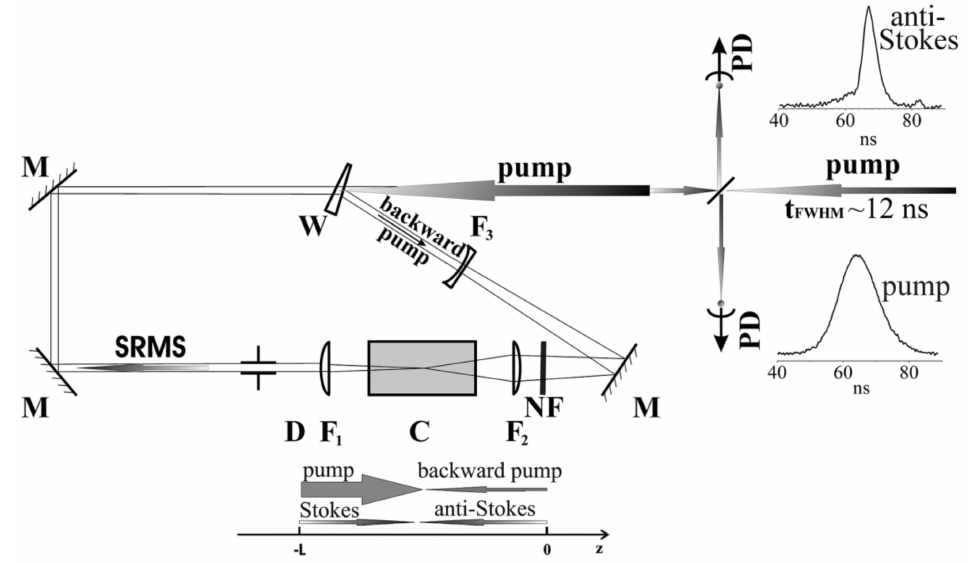
Figure 3. Experimental setup for nanosecond four-wave mixing SRMS generation. It contains: 5 cm interaction cell (C), lenses with the focal lengths 7.5, 5.5, and − 15 cm (F 1 − 3 , respectively), total reflection mirrors (M), the glass wedge (W), the 4 mm aperture (D), the neutral density filter (NF), and two photodiodes PD of ~1 ns resolution. Typical oscilloscope traces of the pump and Anti-Stokes signal pulses are shown at correspondent PD in the right upper corner. The direction map of the pump pulses and scattering signals is shown below the cell